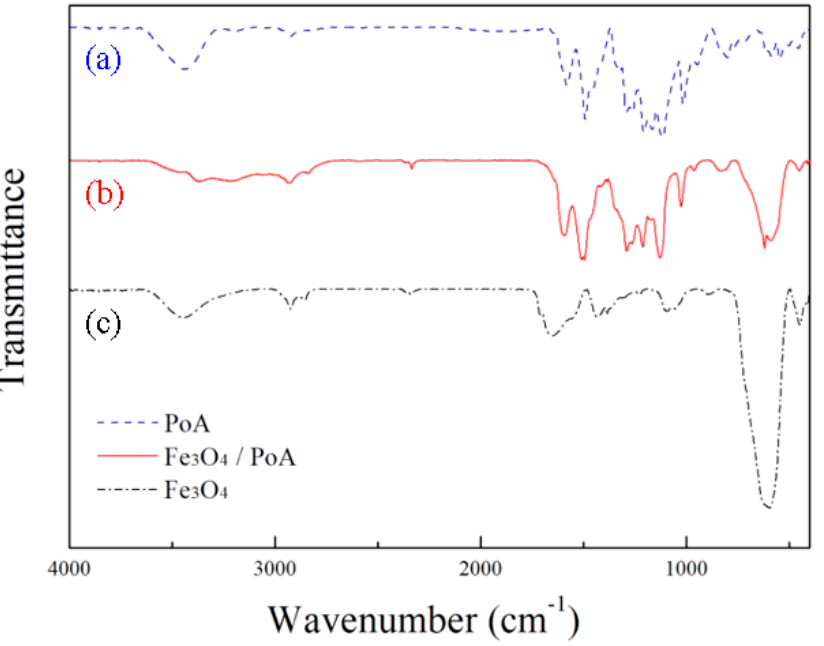
Figure 4. FT-IR absorption spectra of (a) POA, (b) Fe 3 O 4 /POA, and (c) Fe 3 O 4.